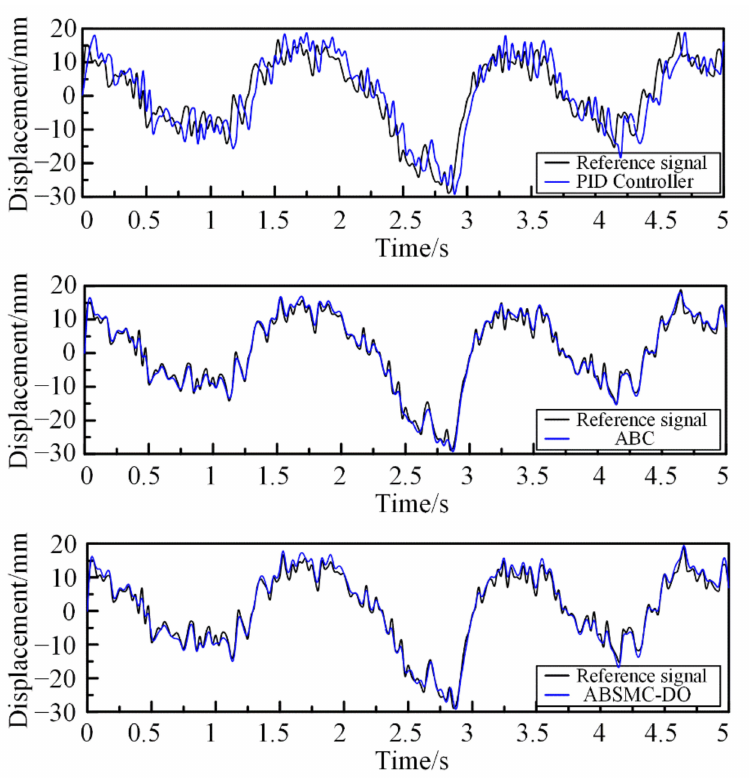
Figure 11. Position deviation control results of the prototype test.